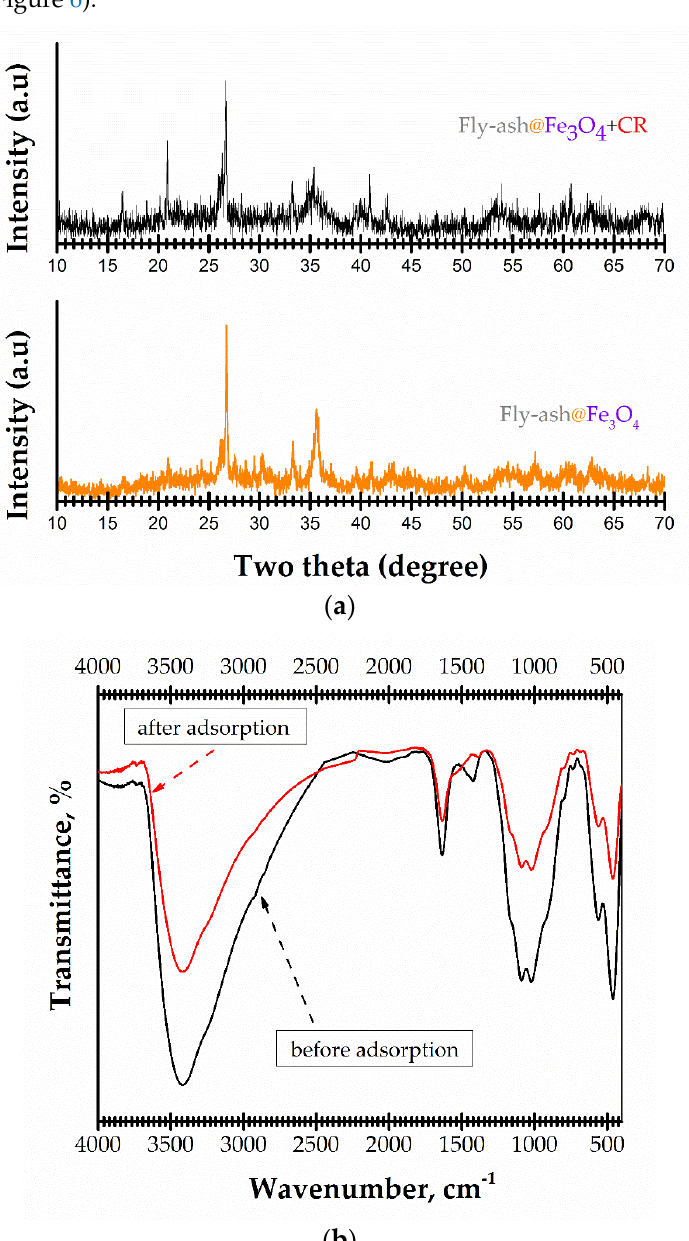
Figure 6. Characterization of Fly-ash@Fe 3 O 4 -loaded adsorbent: ( a ) XRD analysis; ( b ) FTIR analysis.